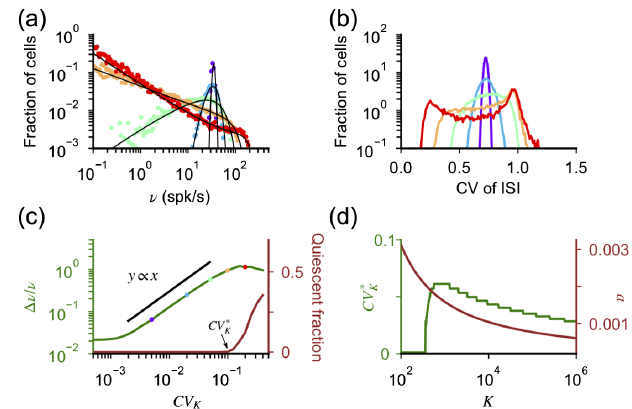
FIG. 4. Effects of heterogeneous connectivity on the network response. (a),(b) Distribution of ν and CV of ISI computed from network simulations (dots) and from the mean field analysis [(a), black lines] for different values of CV [values are indicated K by dots in (c)]. (c) Δ ν = ν (green, left axis) and fraction of quiescent cells (brown, right axis) computed from network simulations as a ≲ CV (cid:3) function of CV . For CV , Δ ν = ν increases linearly, as K K K predicted by the mean field analysis; deviations from linear scaling ≳ CV (cid:3) , when a significant fraction of cells emerge for CV K K is become quiescent. The deviation from linear scaling at low CV K due to a sampling error in estimating the firing rate from simulations. (d) CV (cid:3) as a function of K computed from the mean K field theory (green, leftaxis), with a rescaled accordingto Eq.(14). decays proportionally to a (brown, right axis). For large K , CV (cid:3) K When K is too low, the network is silent and CV (cid:3) ¼ 0 . In (a) – (c), K K ¼ 10 3 , g ¼ 20 , a ¼ 1 . 6 × 10 − 3 , N N N = γ ¼ 10 K , E ¼ X ¼ I 0 . 05 = τ and ν . In network simulations, the dynamics is X ¼ rp run for 20 s using a time step of 50 μ s. Parameters in (d) are as in Fig.